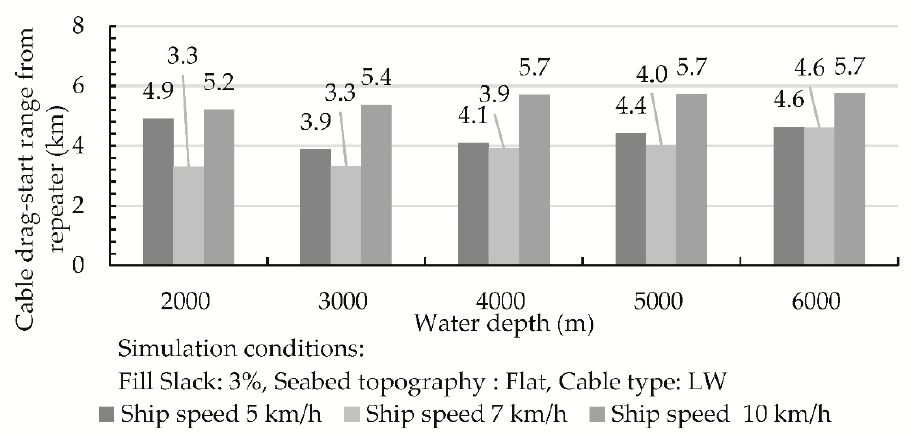
Figure 13. Simulation results of the cable drag-start range caused by laying repeaters in various laying conditions.